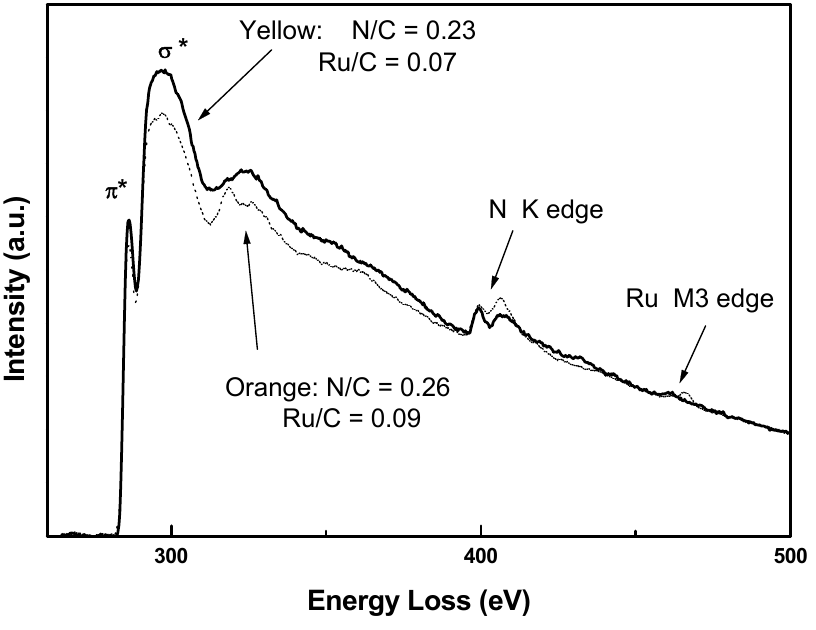
Figure 4. High-energy loss region of EELS spectra showing the K ionization edges from C and N and Ru M edge of yellow (continuous) and orange (dotted) samples. 3